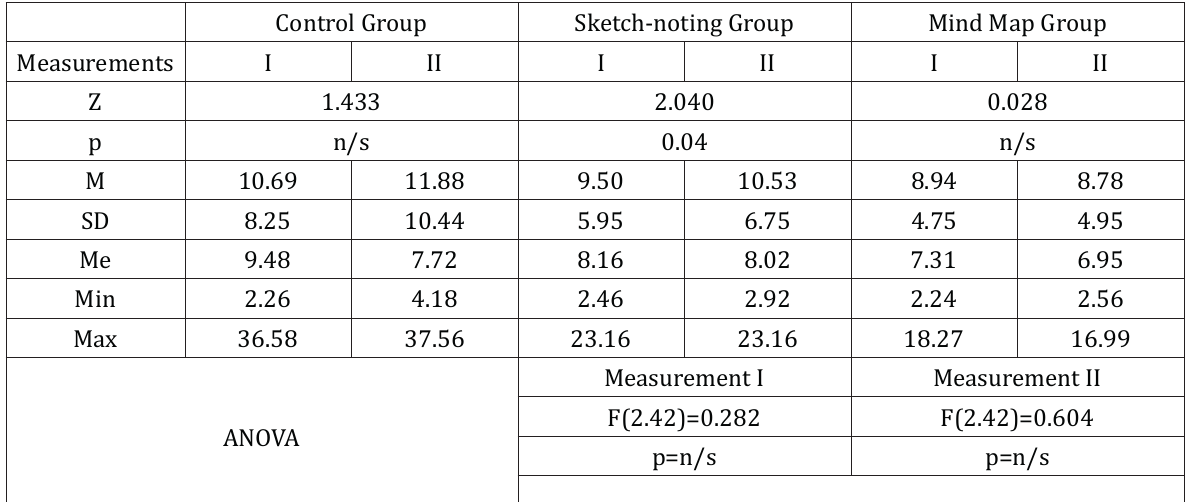
Table 2. Comparison of mean results of the emotional and motivational self-regulation variable (average reaction time) in the first and second measurement